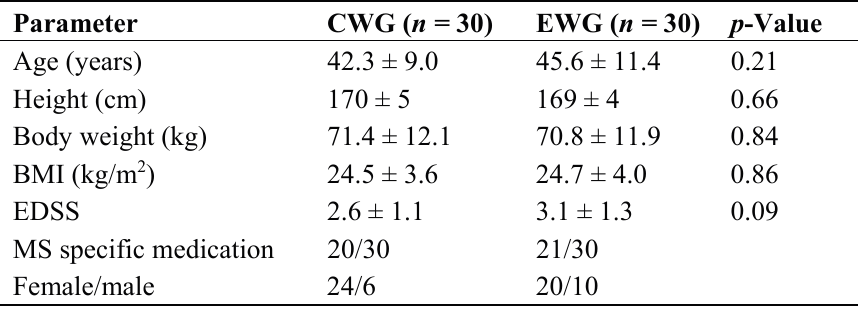
Table 1. Baseline characteristics.